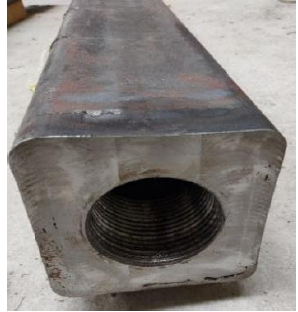
Figure 9. Object picture of column with three upper-end plates.